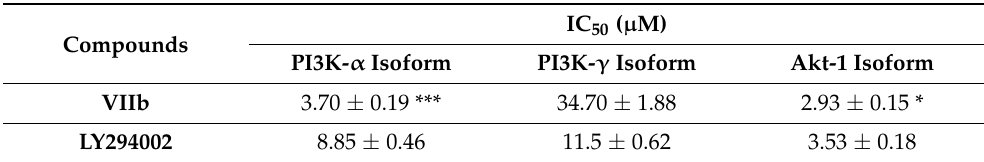
Table 3. IC 50 values ( µ M) for the inhibition of PI3K- α , PI3K- γ , and Akt-1 enzymes following Compound VIIb treatment.